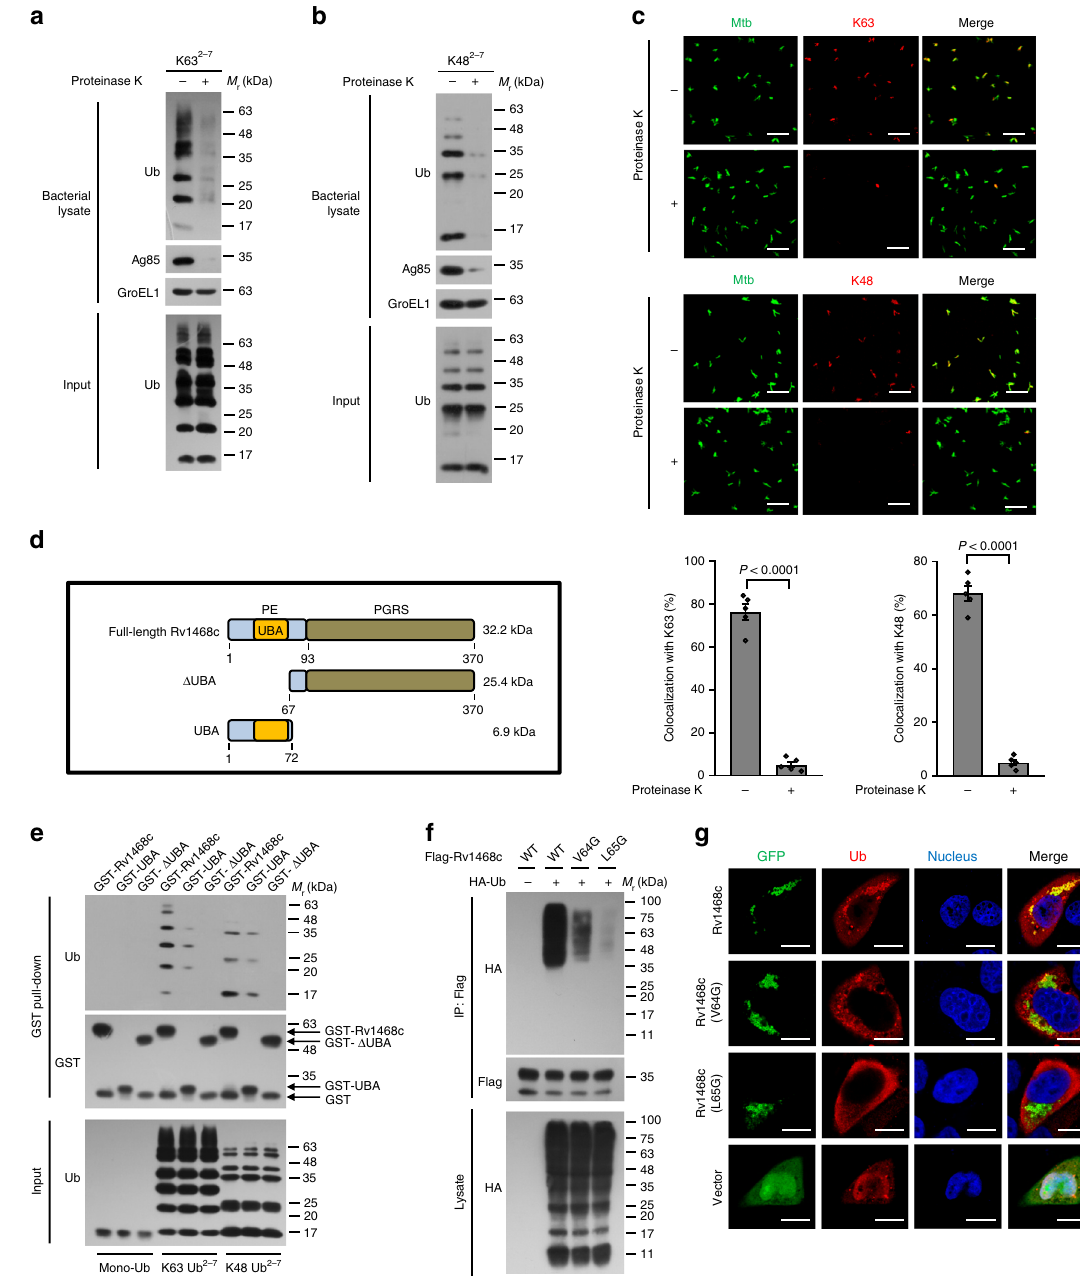
Fig. 1 Mtb Rv1468c directly binds to poly-Ub chains in a UBA-dependent manner. a , b Immunoblot analysis of whole bacterial lysate of Mtb cells pretreated with ( + ) or without ( – ) proteinase K followed by incubation with K63 2 – 7 ( a ) or K48 2 – 7 ( b ) poly-Ub chains at 4 °C for 4 h. c Confocal microscopy analysis for colocalization of pSC301-Mtb stably expressing green fl uorescent protein (GFP) with K63 2 – 7 or K48 2 – 7 Ub chains in vitro. Bacteria (green) treated with ( + ) or without ( – ) proteinase K were further incubated with poly-Ub chains as in a and b , and were then immunostained using anti-Ub antibody (red). Scale bars, 10 μ m. The percent colocalizations of Ub and Mtb are shown at the bottom. A total of 100 bacterial cells were counted. Two-tailed unpaired t - test was performed. d Schematic representation of the Mtb Rv1468c constructs used. e In vitro interaction analysis of Ub and GST-tagged full-length Mtb Rv1468c or the truncated mutants as indicated in d . Puri fi ed recombinant GST-tagged Mtb Rv1468c variants were immobilized on glutathione sepharose resin. Mono-Ub (His 6 -tagged), K63 or K48-linked poly-Ub (Ub 2 – 7 ) was added, and then the protein complexes were assayed by immunoblotting with indicated antibodies. f Immunoblot analysis of proteins immunoprecipitated (IP) with anti-Flag M2 Af fi nity Gel from lysates of HEK293T cells transfected with empty vector ( – ) or hemagglutinin (HA)-tagged Ub ( + ) and Flag-tagged wild-type (WT) Rv1468c or its mutants (V64G or L65G). g Confocal microscopy analysis of HeLa cells cotransfected with vectors encoding HA-tagged Ub (red) and GFP-tagged WT Rv1468c, V64G or L65G mutant (green). Nuclei (blue) were stained with the DNA-binding dye DAPI. Scale bars, 10 μ m. Results are representatives from at least three independent experiments (mean ± s.e.m. of n = 5 in c ). The source data used in c are provided in Source